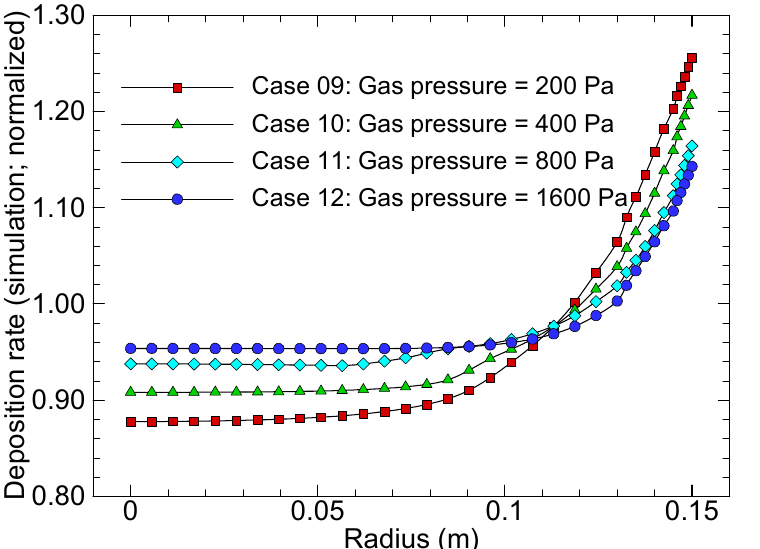
Figure 10. Deposition rate profiles are plotted for Cases 9, 10, 11, and 12. The profiles are normalized with their corresponding averaged values.